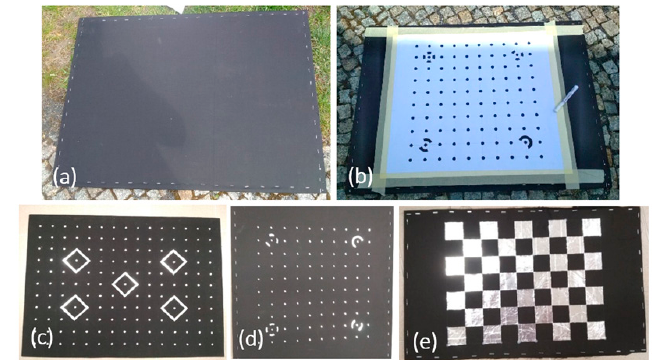
Figure 6. Subsequent stages of constructing calibration fields: ( a ) board–background; ( b ) board with a pattern of calibration targets; ( c – e ) boards dedicated for various software products. Phase I requires preparing stiff support for the calibration board. Phase II requires de- veloping calibration targets for Image Master (Figure 6c), PhotoModeler Scanner (Figure 6d), Matlab (Figure 6e). Test fields for Matlab and PhotoModeler were enlarged, respectively, to A3 and A1 formats. The estimated error resulting from the potential displacement of calibration target is ± 1 mm. This accuracy is acceptable for fast calibration tests. The distance from the camera to the calibration board is related to the software, camera IFOV and GSD (Table